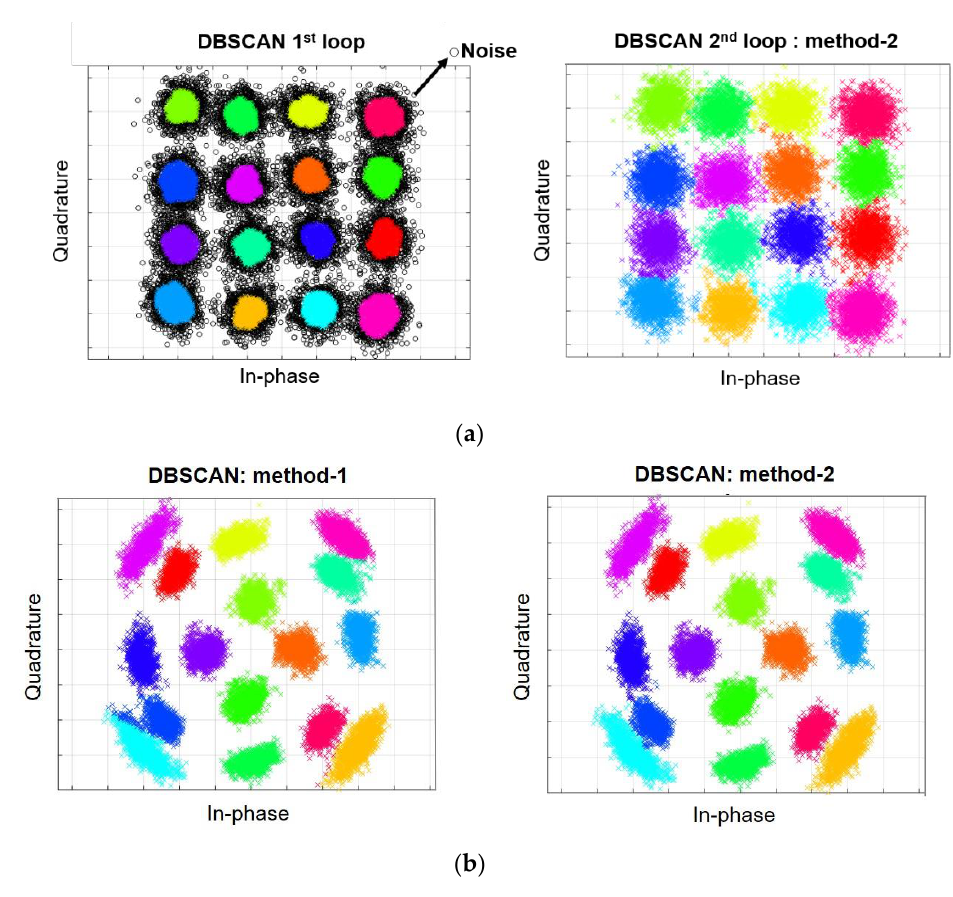
Figure 5. Received constellation diagrams for ( a ) DBSCAN 1st loop (left), method-2 / 2nd loop (right) at + 10 dBm of LOP (OSNR = 15 dB); and ( b ) DBSCAN method-1 (left), method-2 (right) at + 16 dBm of LOP (OSNR = 30 dB).